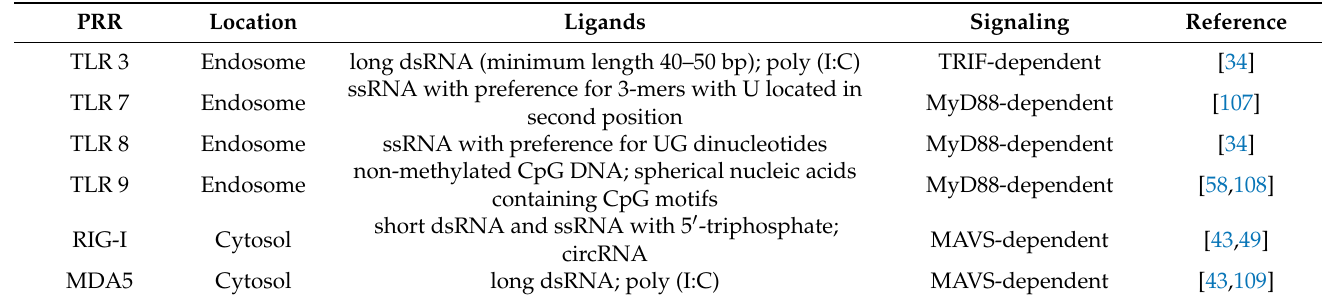
Table 2. PRR ligands.